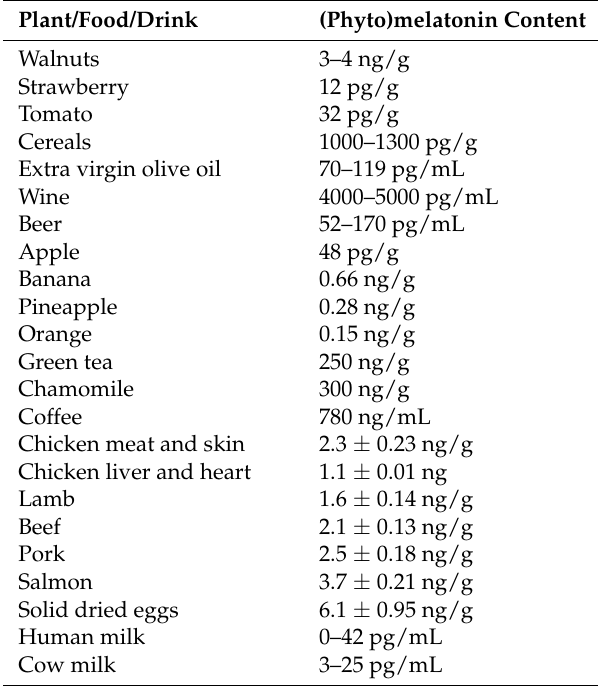
Table 1. Examples of melatonin content in plants, foods and drinks data from: